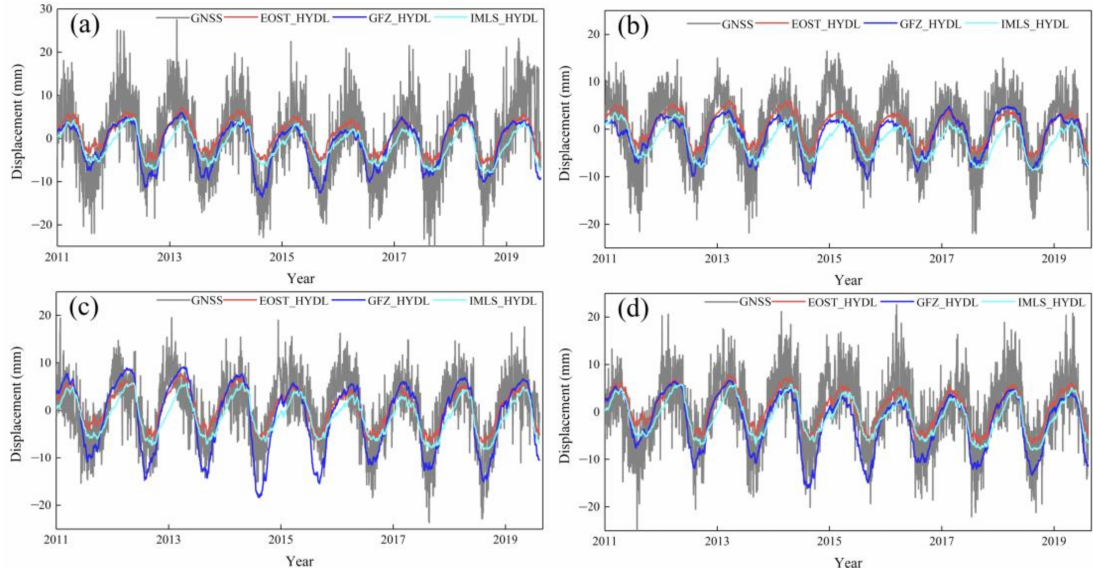
Figure 3. Comparison of the HYDL time series provided by EOST, GFZ, and IMLS with GNSS vertical time series at SCML ( a ), SCXC ( b ), YNLJ ( c ), and YNYS ( d ) stations.